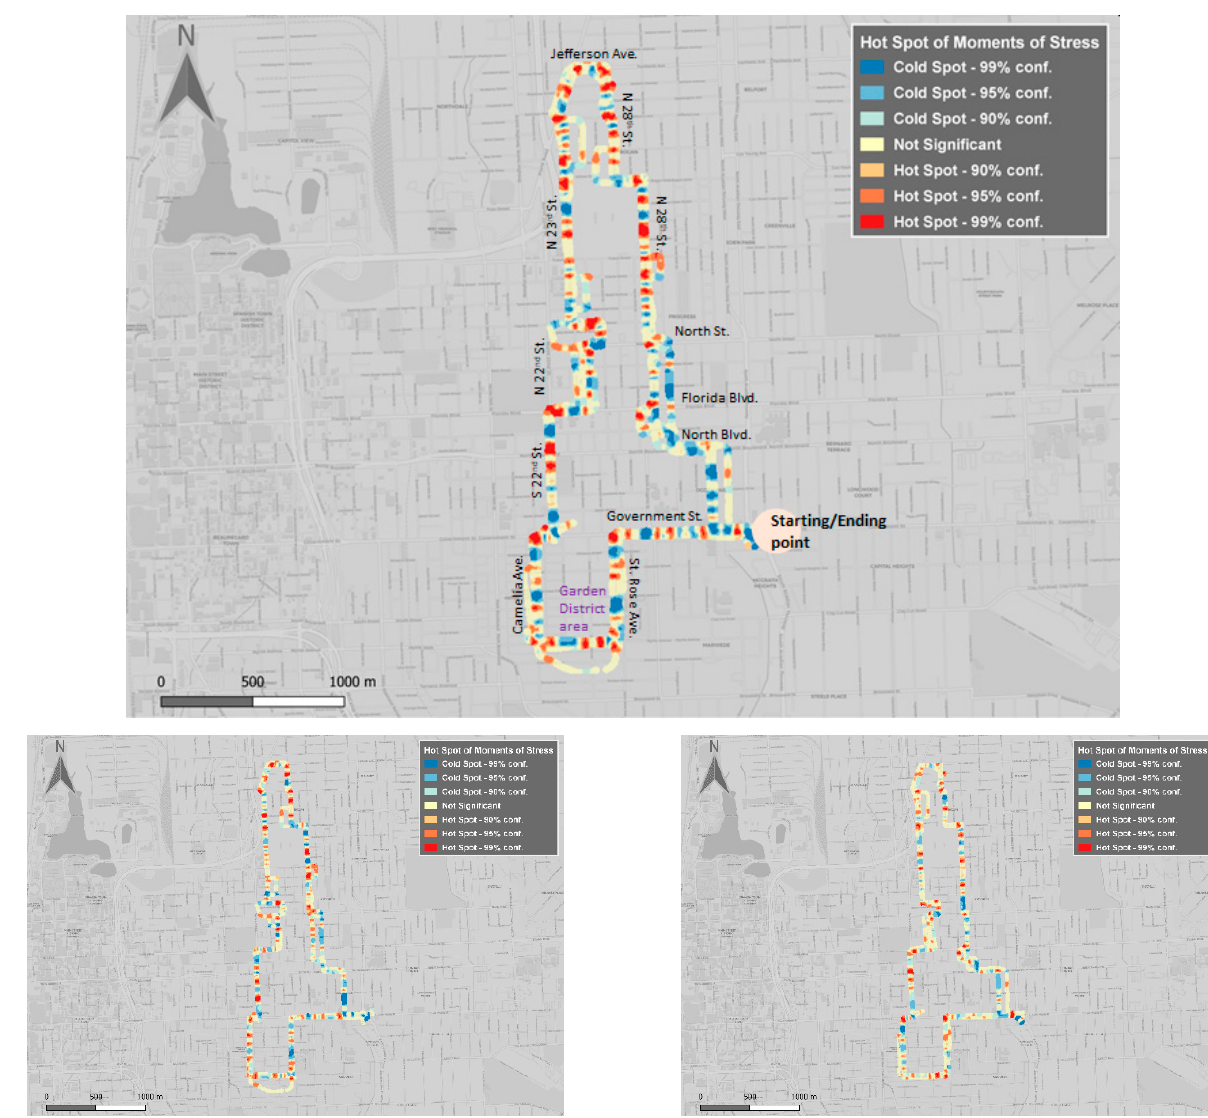
Figure 12. Spatial distribution of moments of stress (MOS) of all participants (top), five Figure